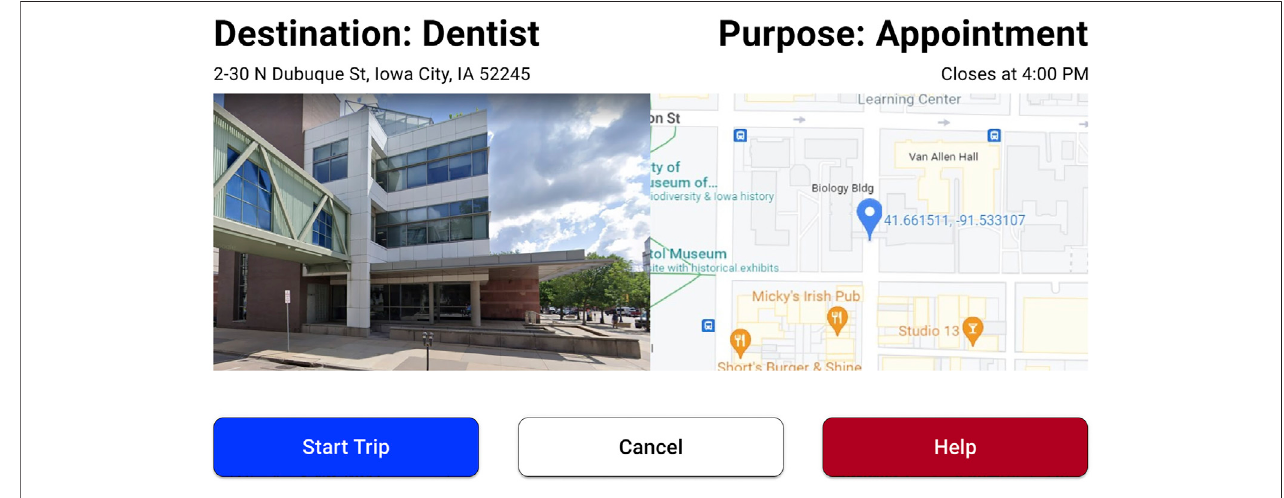
FIGURE 7 | Prototype of the destination con fi rmation